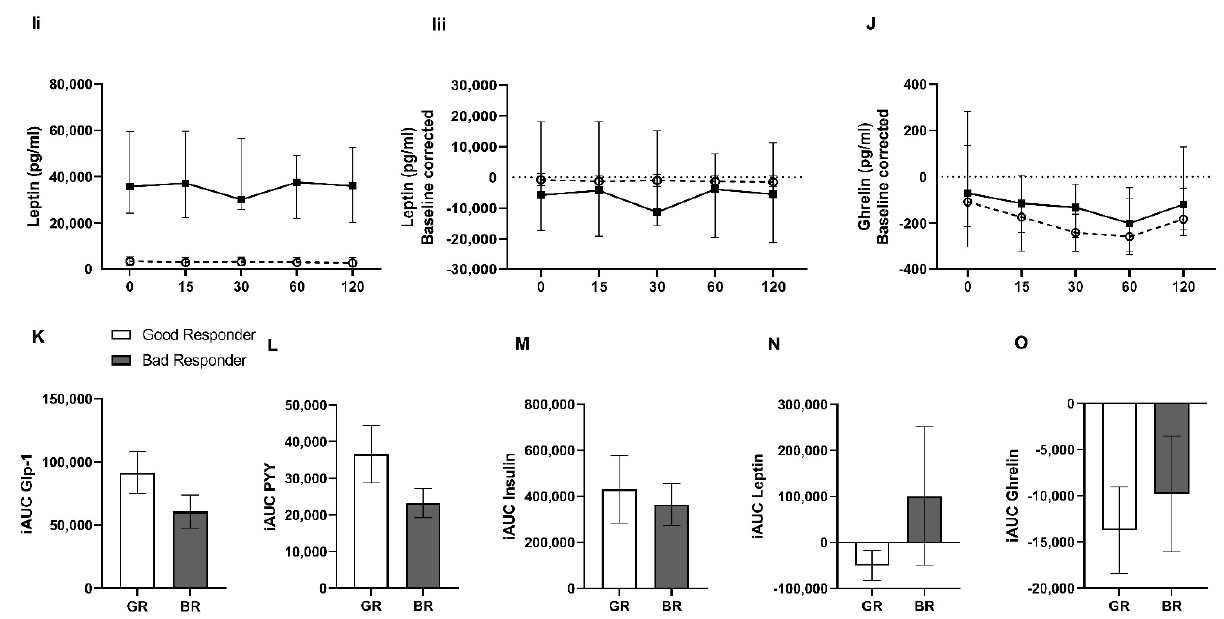
Figure 2. Visual analogue scale (VAS) data of hunger, satiety and palatability ratings ( A – C ) and gut hormone concentration ( F – J ) during standardized mixed-meal test at time points 15, 30, 60 and 120 min after ingestion of a test meal in the good and bad responder groups. Leptin and ghrelin levels ( G , H ) shown after baseline correction to account for weight-dependent effects. Data presented as median ± IQR ( A , B , D – H ); Boxplot of Palatability (whiskers 1.5 × IQR). Incremental areas under the curve (iAUC) ± S.E.M. for hunger and satiety and gut hormones ( K – O